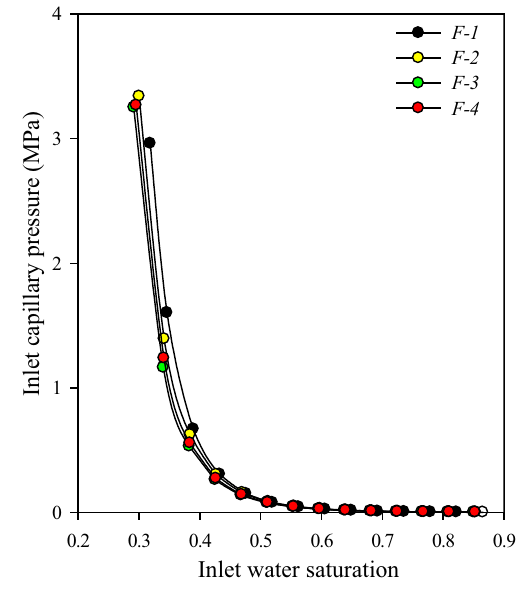
Fig. 4 Inlet water saturation versus inlet capillary pressure